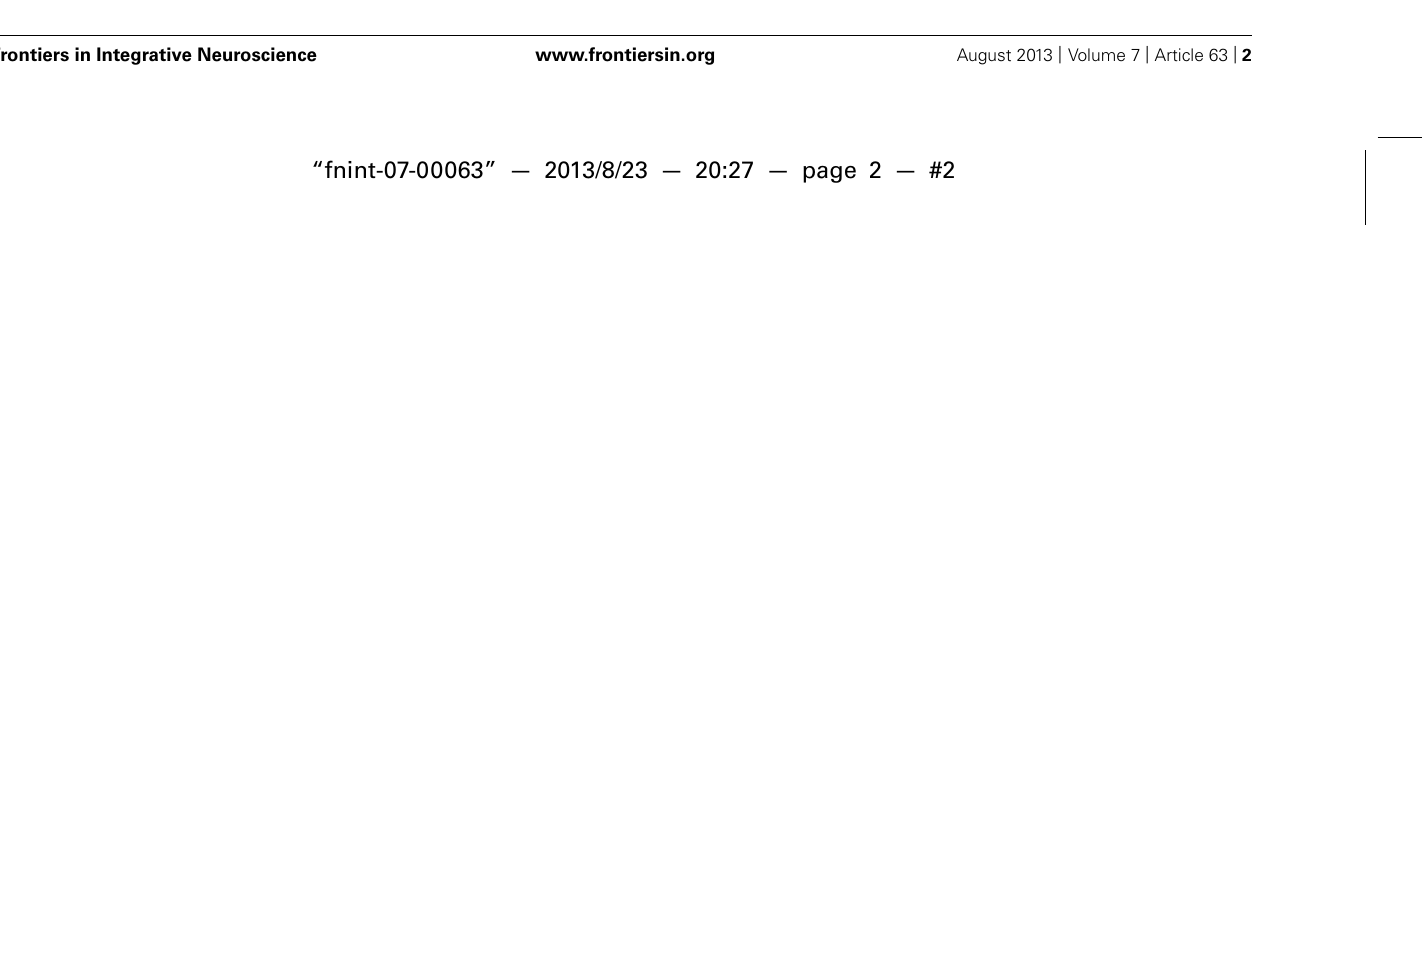
gray matter is not shown. Colored filled circles represent excitatory neurons projecting axons that send reentrant action potentials bidirectionally between areas. Colored arrowheads represent presynaptic terminals of these axons. AP → indicates direction of